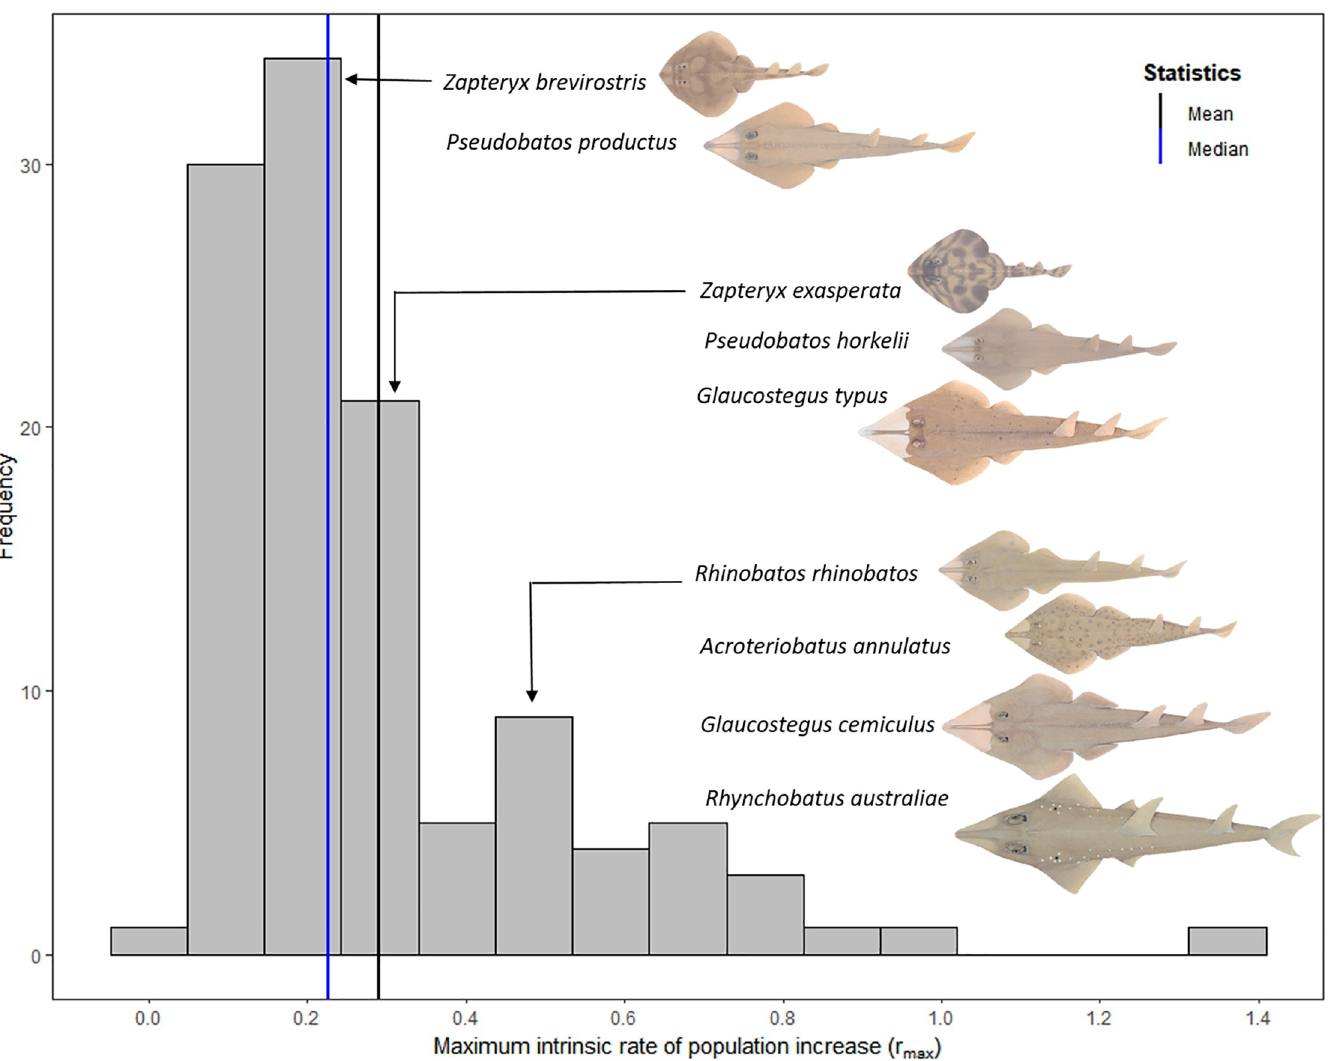
Fig 5. The frequency of the r max values predicted for 115 chondrichthyans, including the nine shovelnose ray species. The reciprocal of lifespan natural mortality and species are grouped by their r values. Black line denote the mean ( r = 0.30) and blue line represents the median ( r estimator was used to estimate r max max max 0.23). The nine shovelnose rays species are displayed on the figure and species illustrations are from Last et al . [75].